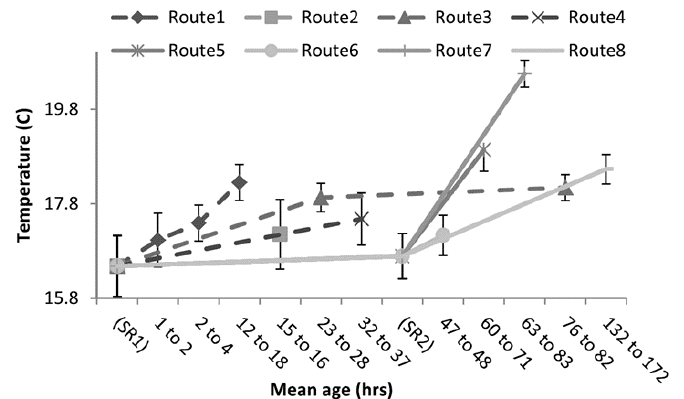
Figure 3. Example of simulation of the temperature in the DWDS [10].